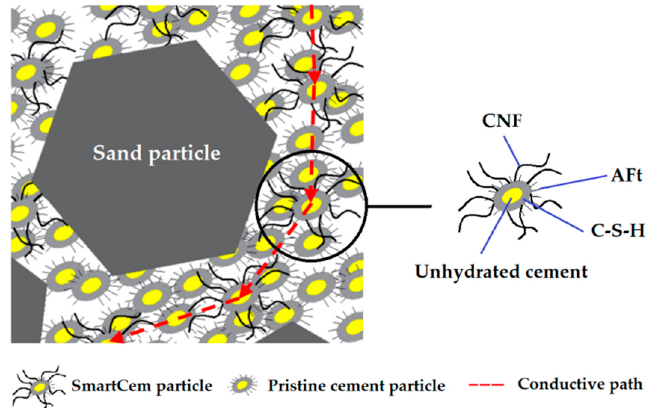
Figure 11. SmartCem with attached carbon nanofibers in hydrated cement matrix.